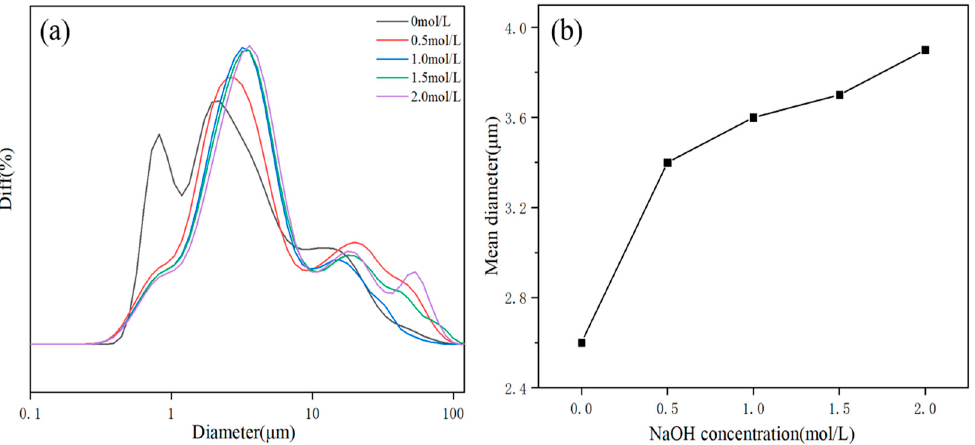
Figure 4. The particle size distribution diagram ( a ) and mean diameter ( b ) of MH powders. Diff,